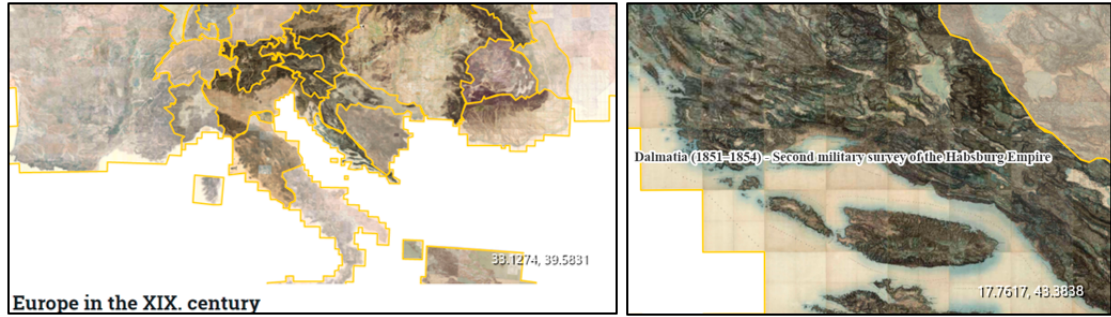
Figure 2. Map of Europe in the XIX. Century ( left ), Split-Dalmatian County in the XIX. Century ( right ).